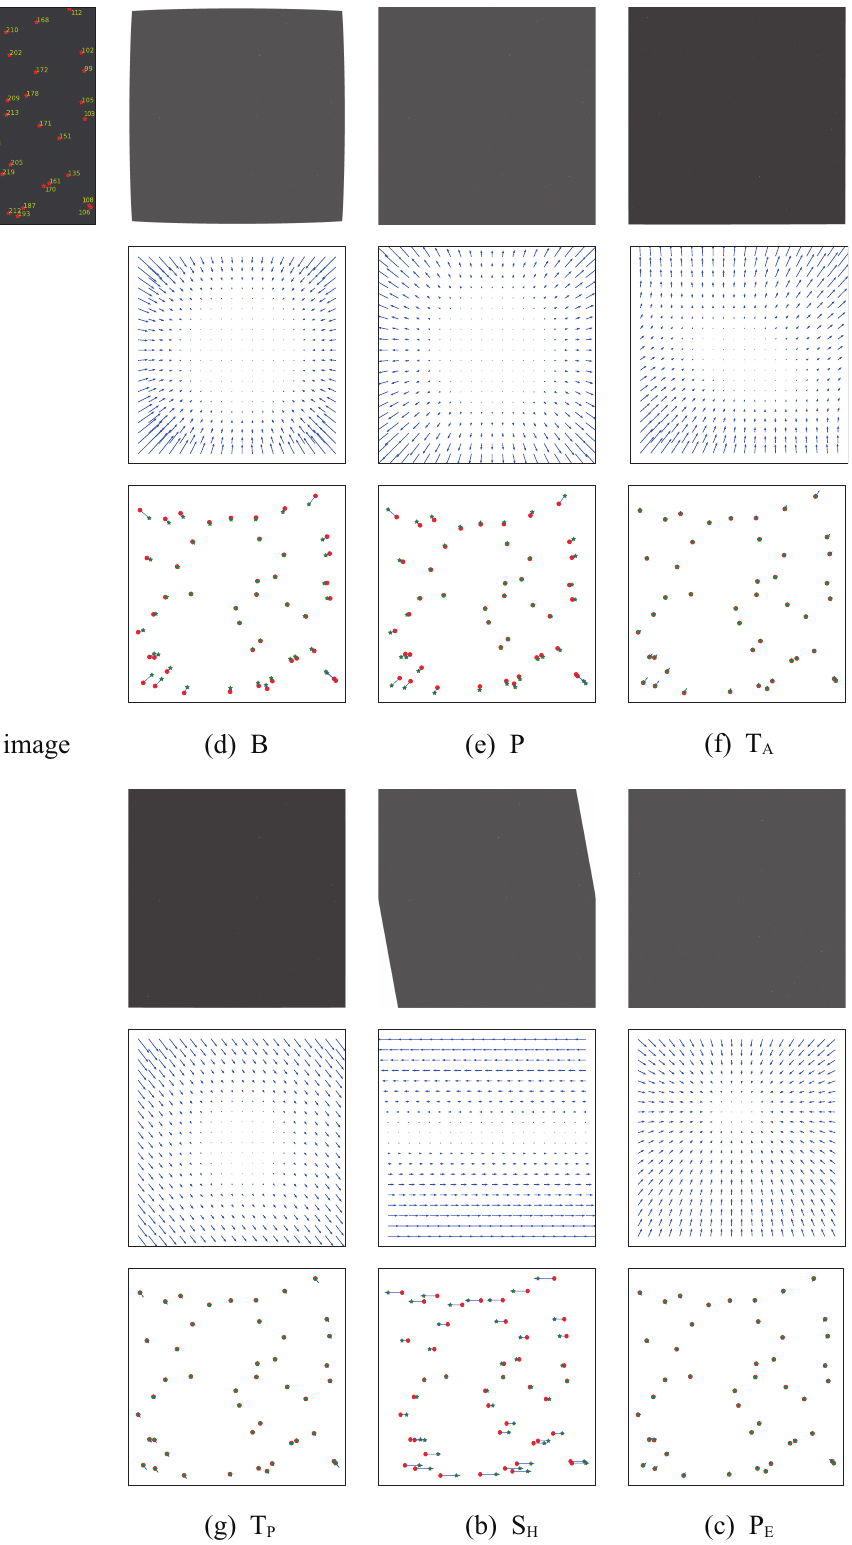
Figure 2. Various optical distortions models, ( a ) the star image without distortion and star images with distortion of ( b ) shear, ( c ) perspective, ( d ) barrel, ( e ) pincushion, ( f ) tangential and ( g ) thin prism. The second line is the distortion flow of pixels for various distortion models. The third line is the distortion flow of the starspot